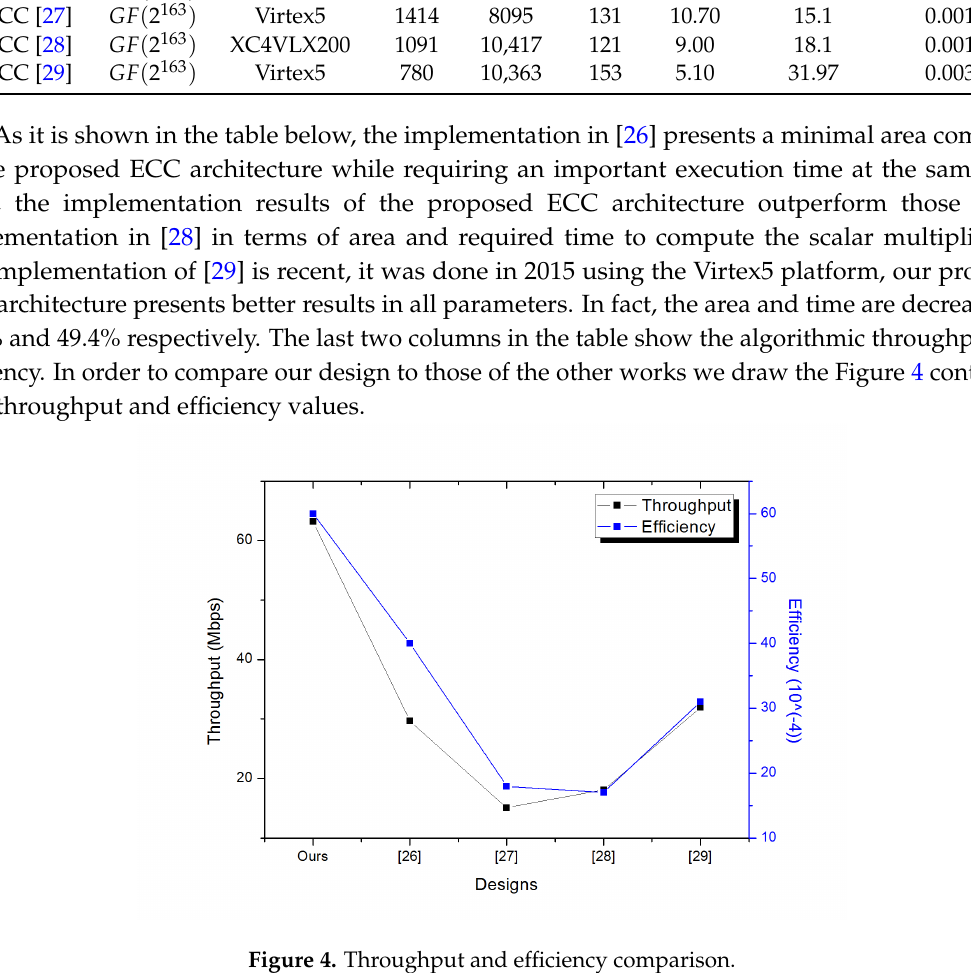
Figure 4. Throughput and efficiency